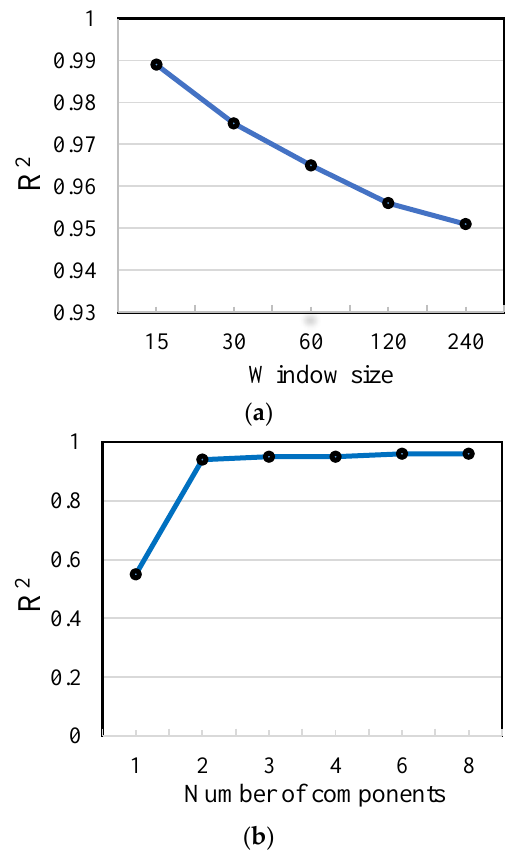
Figure 6. R 2 values between the original data and singular spectrum analysis (SSA) reconstruction in a time series with 730 data with different window sizes ( a ) and different numbers of components ( b ).